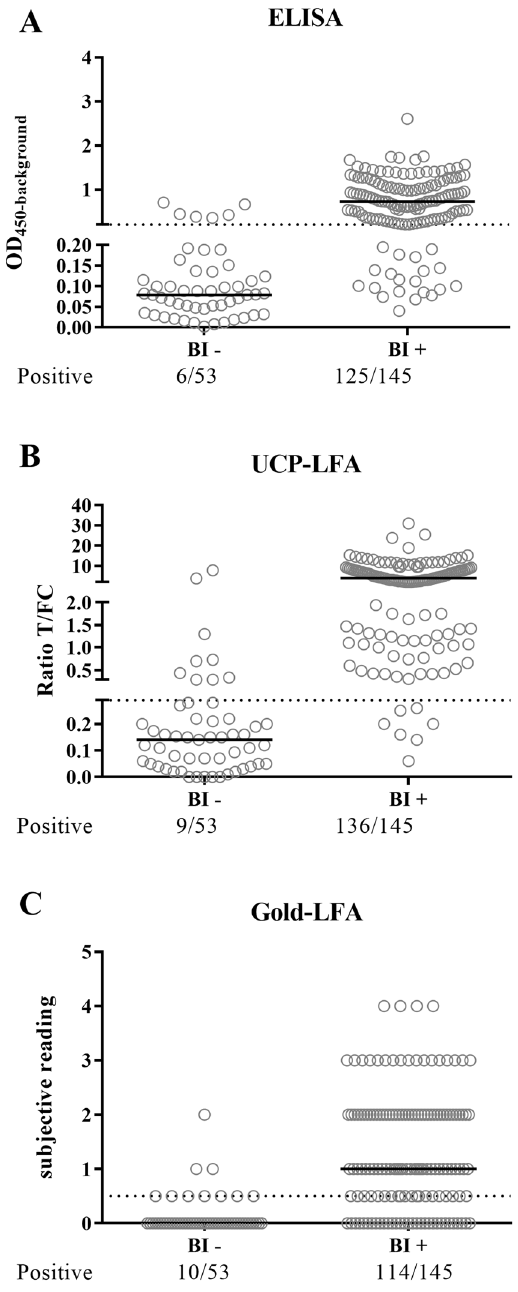
Figure 3. Test correspondence with bacterial index. Leprosy patients of which the BI was assessed were stratified by bacterial index (BI negative [n = 53] and positive [n = 145]) to evaluate the correlation between BI and LF test results. ( A ) ELISA data stratified by BI, the cut-off of OD 450 -background ( = 0.2) is visualized by the dotted line. 125 BI + patients and 6 BI − patients showed a positive result in ELISA. Values significantly differed between BI − and BI + patients (p < 0.0001) ( B ) UCP-LFA data stratified by BI, the positive cut-off of ratio 0.29 is visualized by the dotted line. 136 BI + patients and 9 BI − negative patients showed a positive result in the UCP-LFA. Values significantly differed between BI − and BI + patients (p < 0.0001) ( C ) Gold-LFA data stratified by BI, the cut-off for a positively scored samples (observed test band > 0.5) is visualized by the dotted line. 114 BI + patients and 10 BI − patients were scored as positive in the Gold-LFA. Values significantly differed between BI − and BI + patients (p <